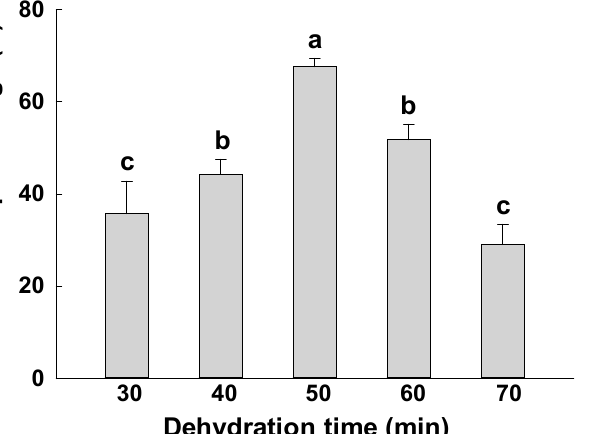
Figure 4. Effects of dehydration time on cell survival percentage of F. mandshurica EC after cryopreservation by vitrification. Note: Different letters are significantly different from each other at p < 0.05, using Duncan’s Multiple Range Test.